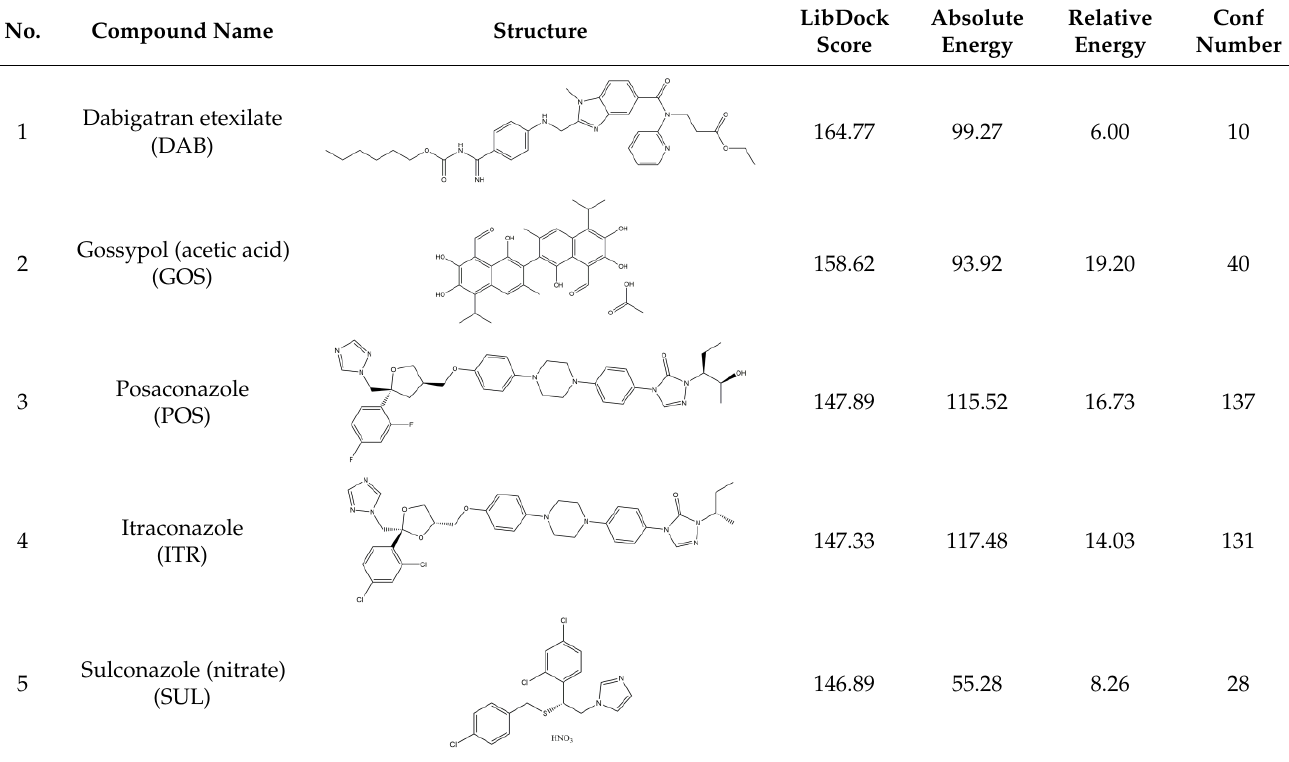
Table 1. Top five ranked compounds with LibDock scores.